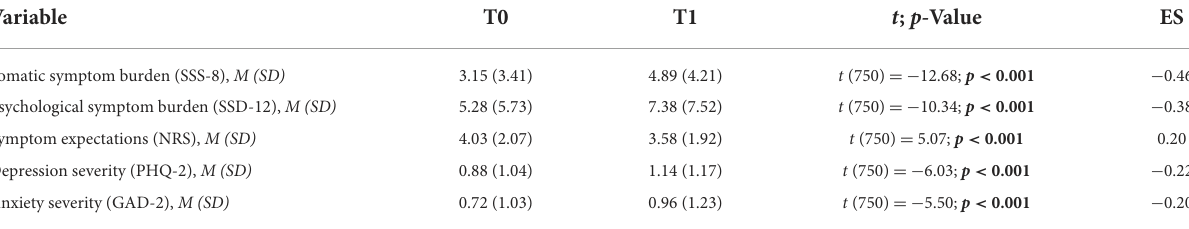
TABLE 1 Comparison between study variables at T0 and T1 ( n = 751).